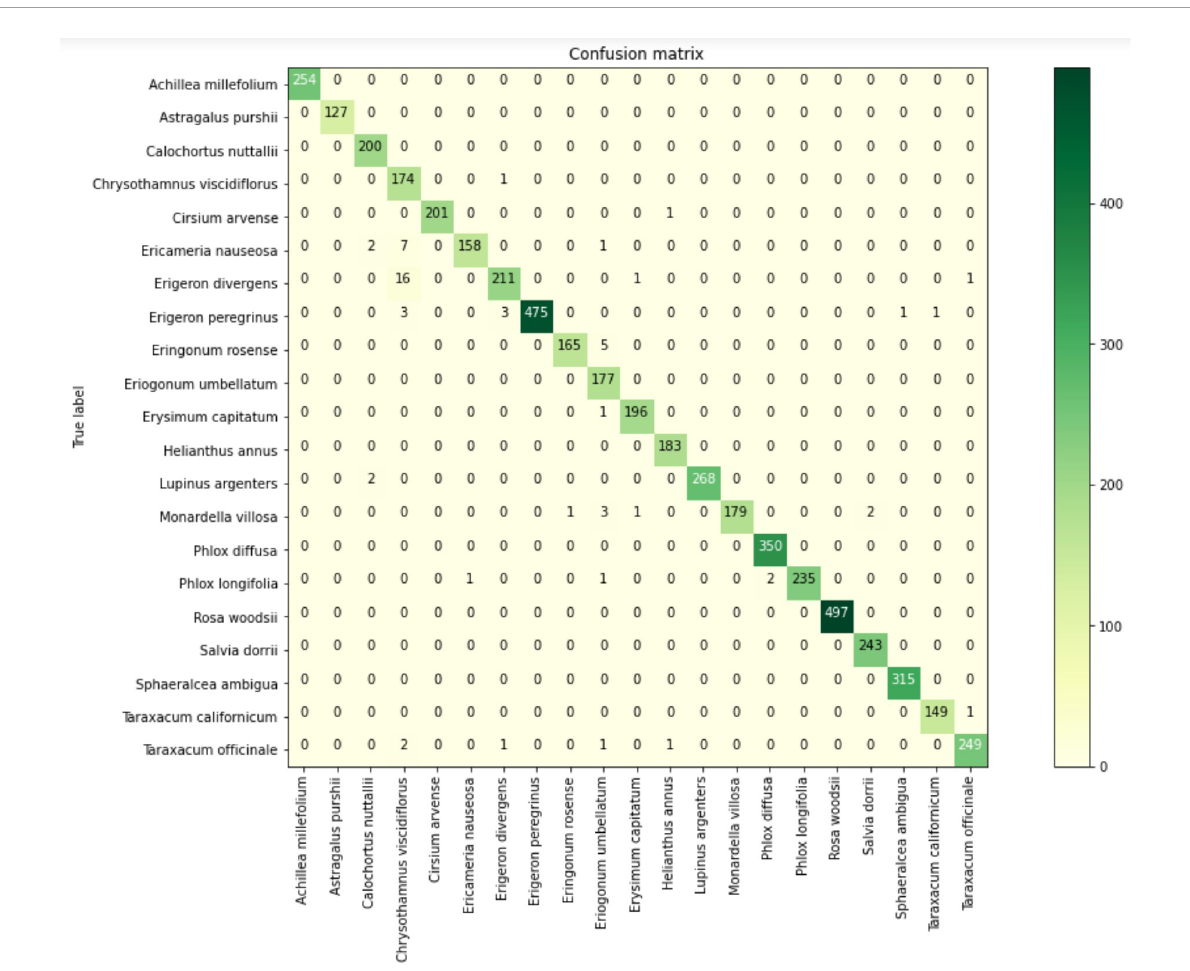
FIGURE6 VGG19 confusion matrix for the 21 pollen species used for the training dataset pollen images from the Great Basin. Rows are species identities and columns are convolutional neural network (CNN) species assignments. The color bar indicates frequency, with dark green being most frequent. The diagonal elements are frequency of correctly classified outcomes, while misclassified outcomes are on the off